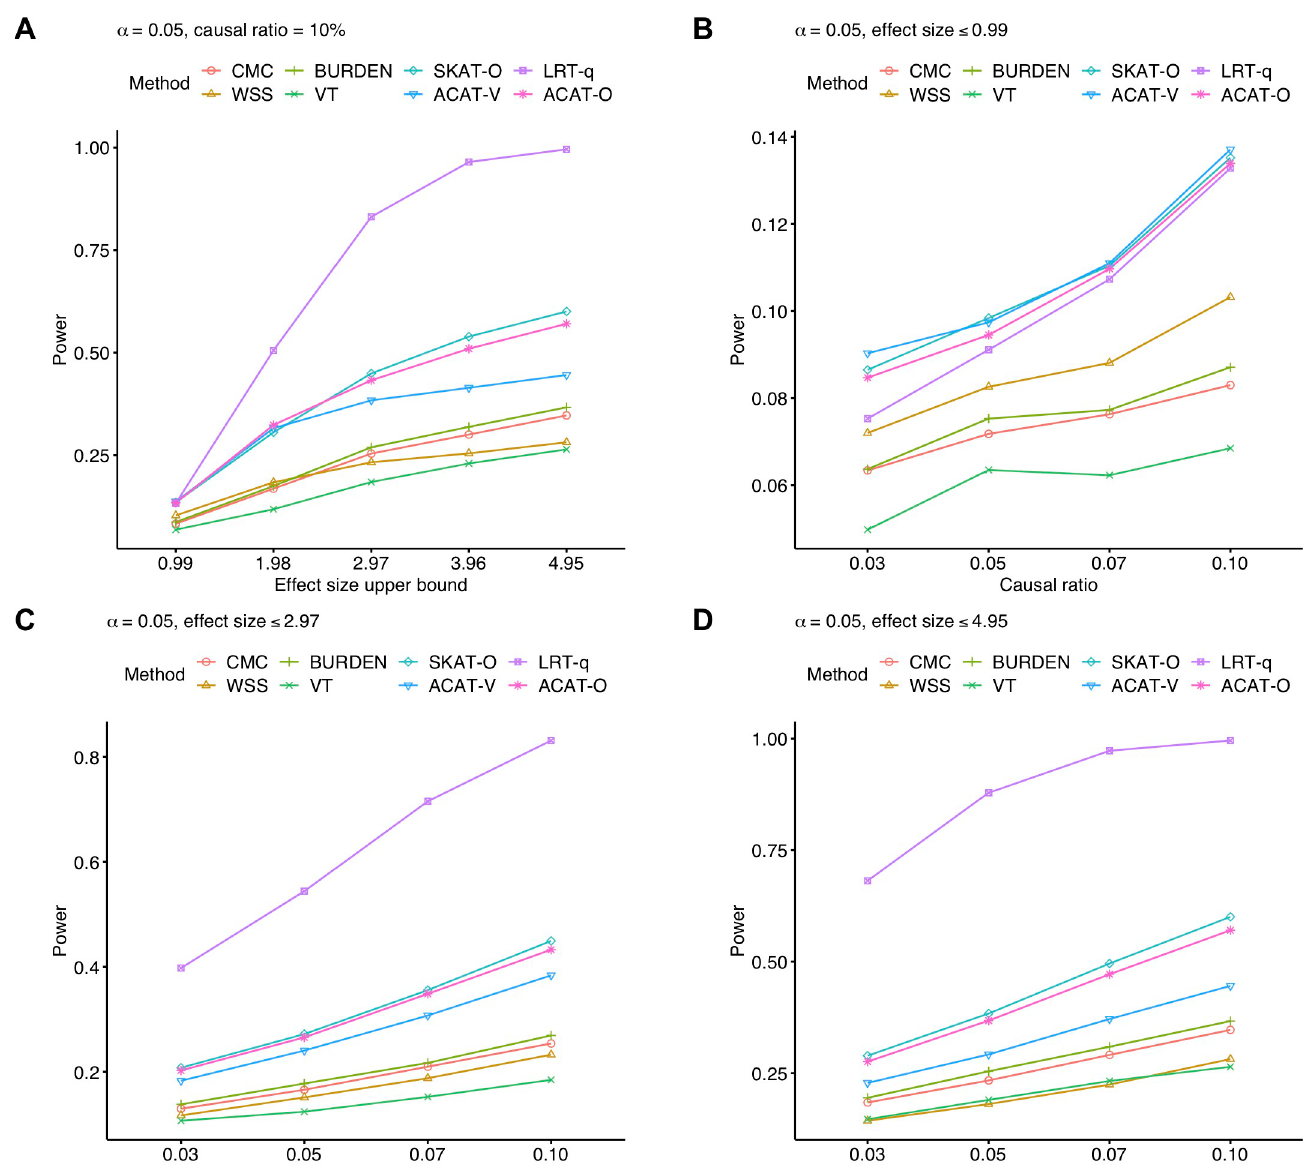
Fig 1. Power comparison between LRT-q and seven existing methods on simulated data. A. for different effect sizes and fixed causal ratio (10%), and for fixed effect sizes (B. � 0.99, C. � 2.97, D. � 4.95) and various causal ratios. Significance level α = 0.05.